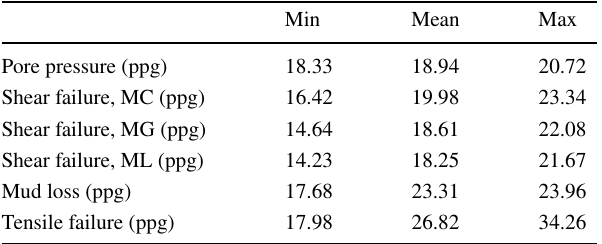
Table 15 The ranges of boundaries of pore pressure, shear failure (for different failure criteria), mud loss and tensile failure (from the results of the safe mud weight window) Min Mean Max